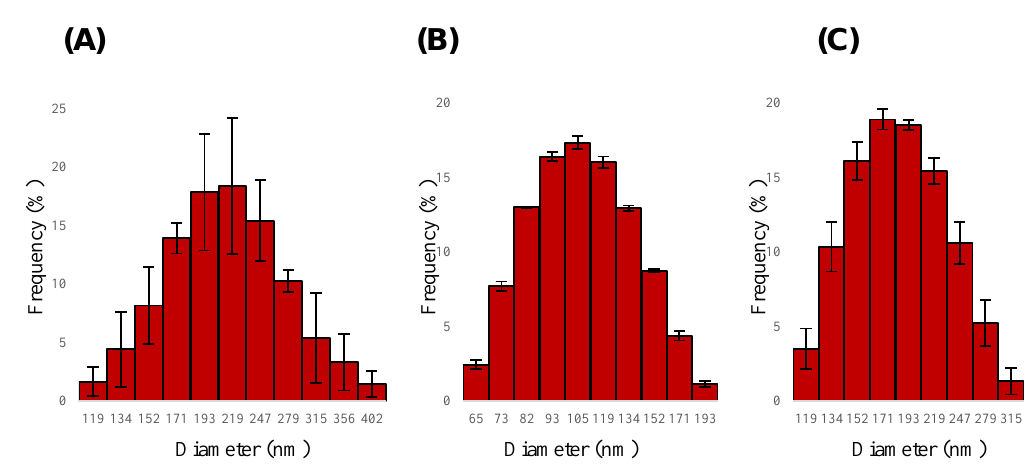
Figure 2. Size profiles of nanoparticles from PEG derivatives, measured by DLS. ( A ) Galactoconjugate 20 . ( B ) Galactoconjugate 24 . ( C ) Mannoconjugate 25 .